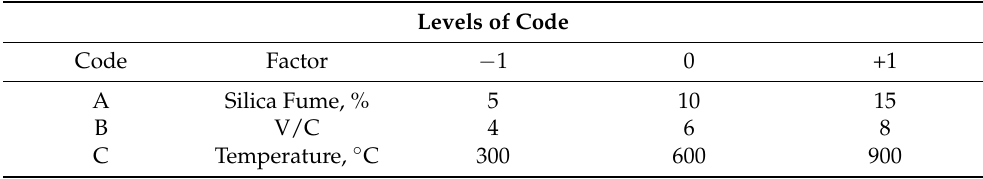
Table 2. Independent variables and their